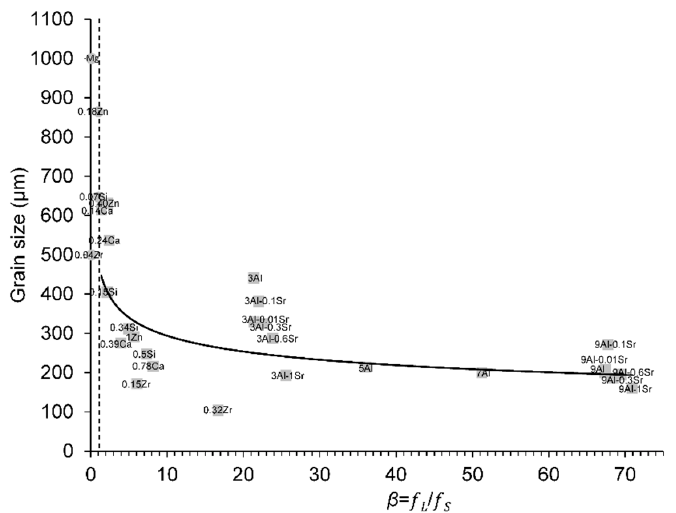
Figure 6. Variation in grain size values from Lee et al., data from [29] with the true β values at ∆ T = 0.5 K for different solute additions in binary and ternary Mg alloys. The dashed line corresponds to the true β of 1.14 (CET criterion) [16]. Circle points represent true β < 1.14. The Mg circle point